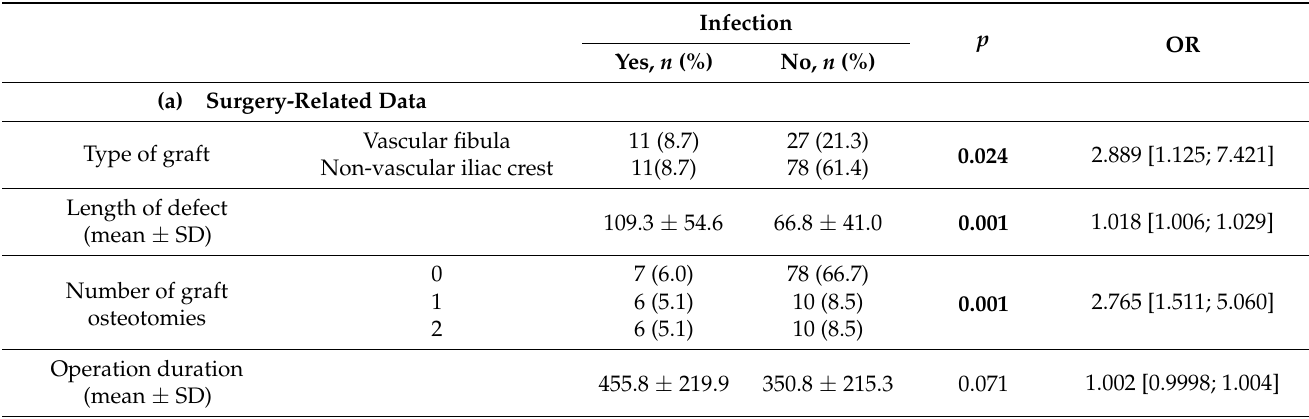
Table 8. Univariate Analysis of Risk Factors on